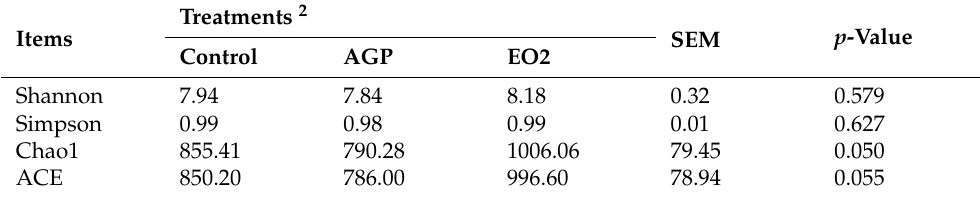
Table 5. Effect of dietary supplementation with oregano essential oil on alpha diversity in cecum 1